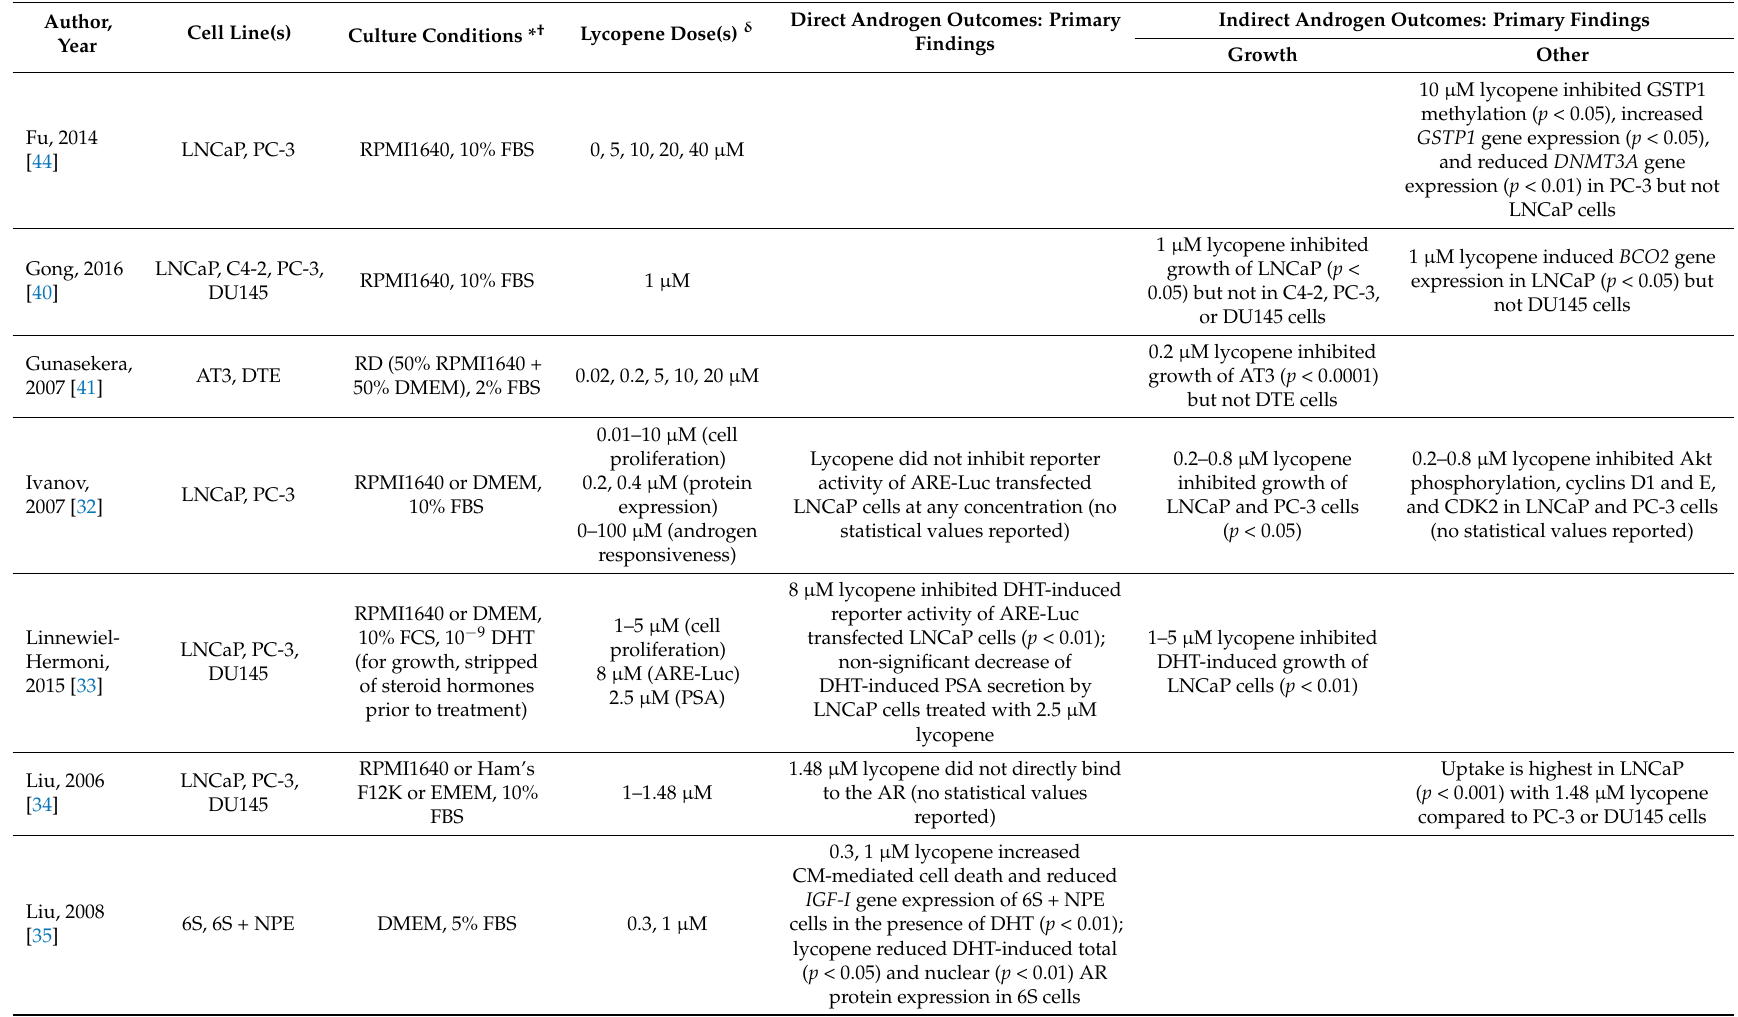
Table 2. Characteristics of included cell culture